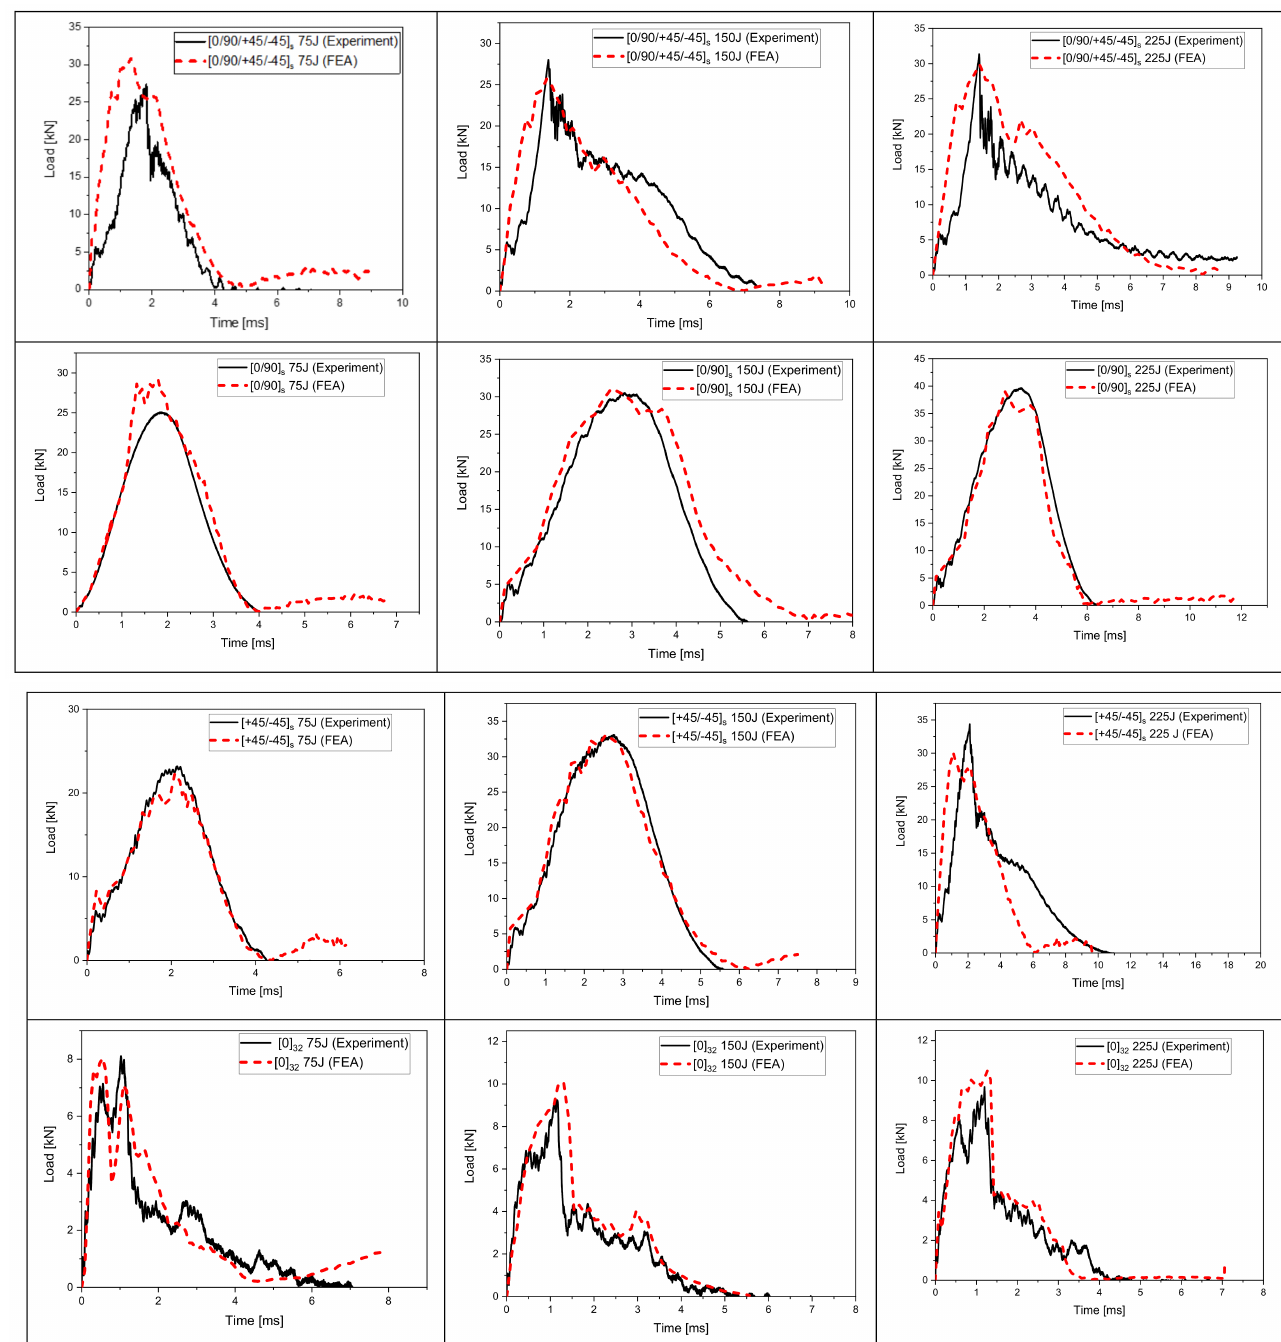
Figure 7. Comparison of the load-time curves between the experimental and FE analysis